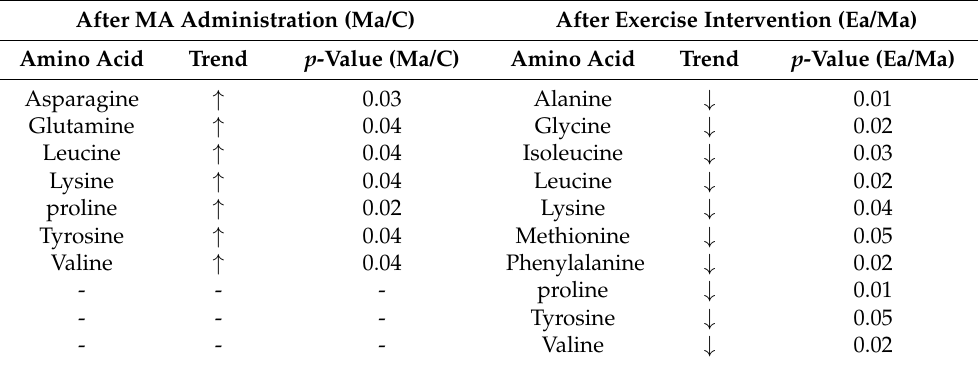
Table 2. The relationship of amino acid level changes between the three groups of mice. After MA Administration (Ma/C)